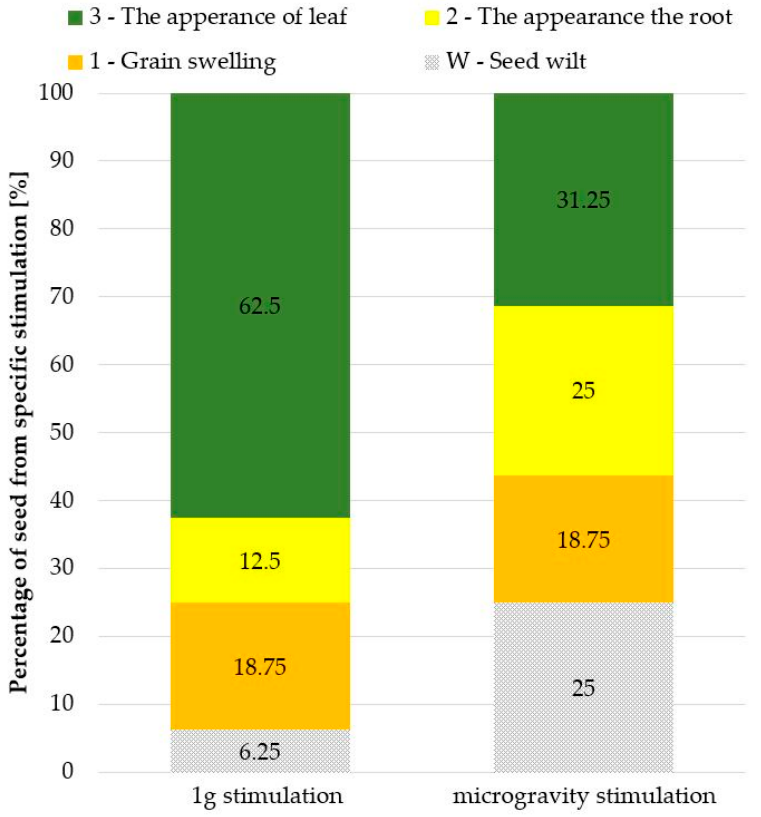
Figure 7. Percentage comparison of growth phases achieved under 1 g stimulation or micrograv- ity.